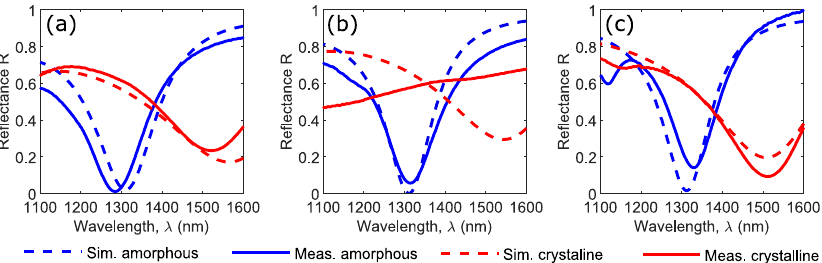
Figure 5. Measured (solid lines) and simulated (dashed lines) reflectance spectra of Si–GST–Si hybrid metasurface devices with GST layer in amorphous (blue lines) and crystalline (red lines) phases for ( a ) Al/Al 2 O 3 bottom plane (Design 1), ( b ) Au bottom plane (Design 2), and ( c ) Au/Si 3 N 4 bottom plane (Design 3).